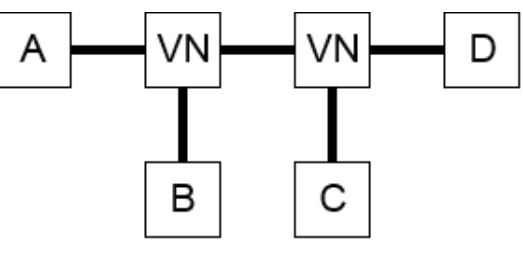
Figure 3. Illustration of an isomorphism topology that includes two virtual nodes (VNs) and four first-degree components (A–D). This results in 24 different possible configurations, of which 23 are